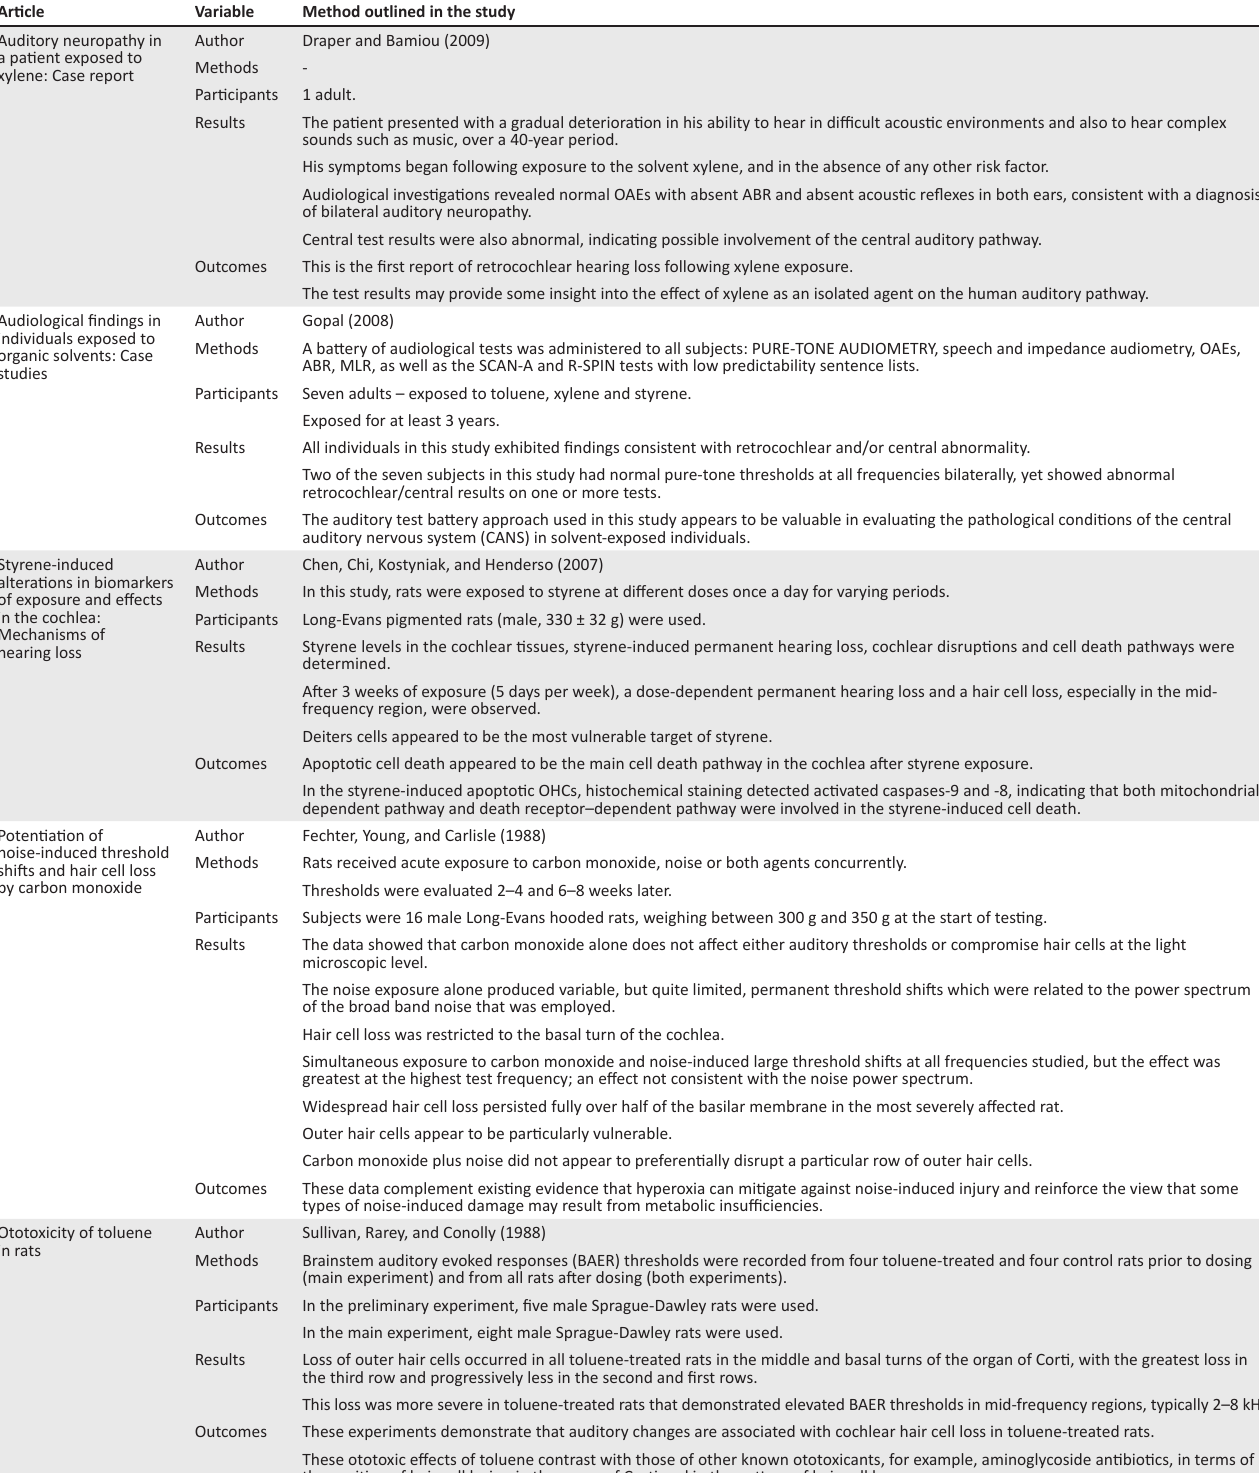
TABLE 1-A2: Characteristics of excluded studies. Variable Method outlined in the